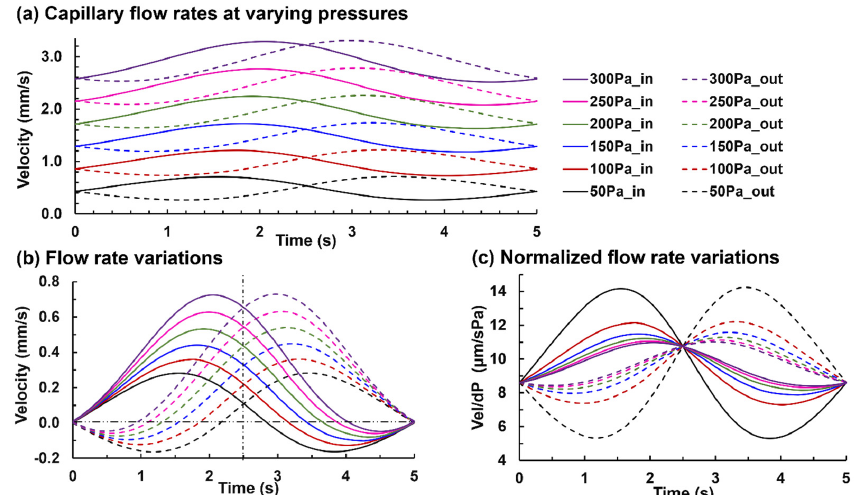
Figure 5. Effect of the capillary pressure drop: ( a ) instantaneous capillary flow velocities within one respiration cycle at varying pressure drops, ( b ) replot the instantaneous velocities minus the average, and ( c ) normalized the instantaneous flow velocities by the pressure drop.